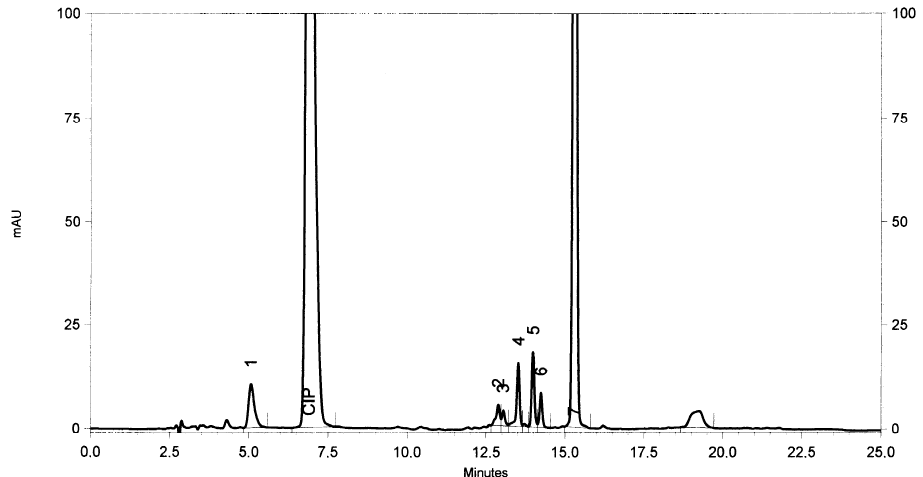
Figure 4. Chromatogram of the CIP oxidized by ACVA after incubation for 72 h at 50 °C.